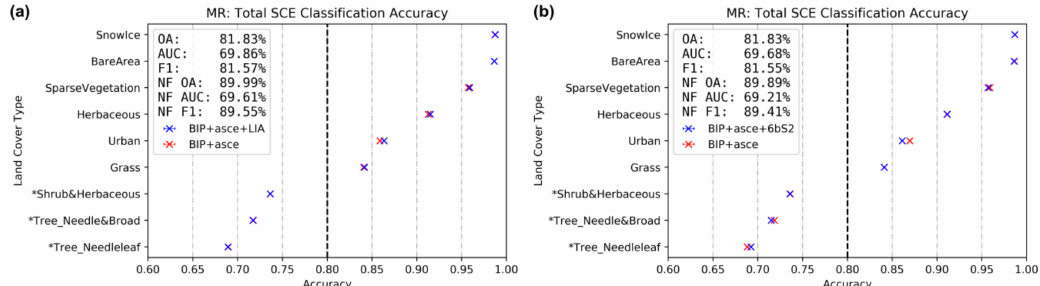
Figure 8. Examination of the accuracy improvement benefits of employing ( a ) SAR local incidence angle (LIA) and ( b ) Sentinel-2 multi-bands imagery on the performance of the model for the Monte Rosa (MR) region. Di ff erent classification accuracies based on di ff erent input combinations are marked in di ff erent colors, and the accuracy for each land cover class is marked in the same horizontal axis. SAR-based observations, including backscatter, interferometric SAR (InSAR) coherence, and polarimetric (PolSAR) H / A / α parameters are abbreviated as B, I, and P, respectively. Topographical factors, including aspect, slope, curvature, and elevation are abbreviated as a, s, c, and e, respectively. Six bands of Sentinel-2 imagery is abbreviated as